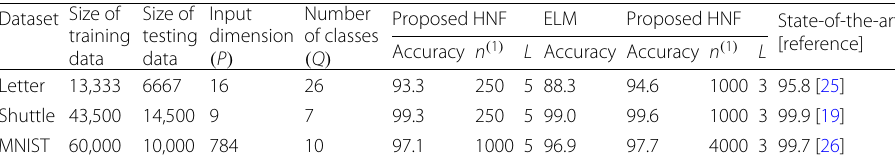
Table 1 Test classification accuracy of the proposed HNF for different datasets using random matrices Dataset Size of training